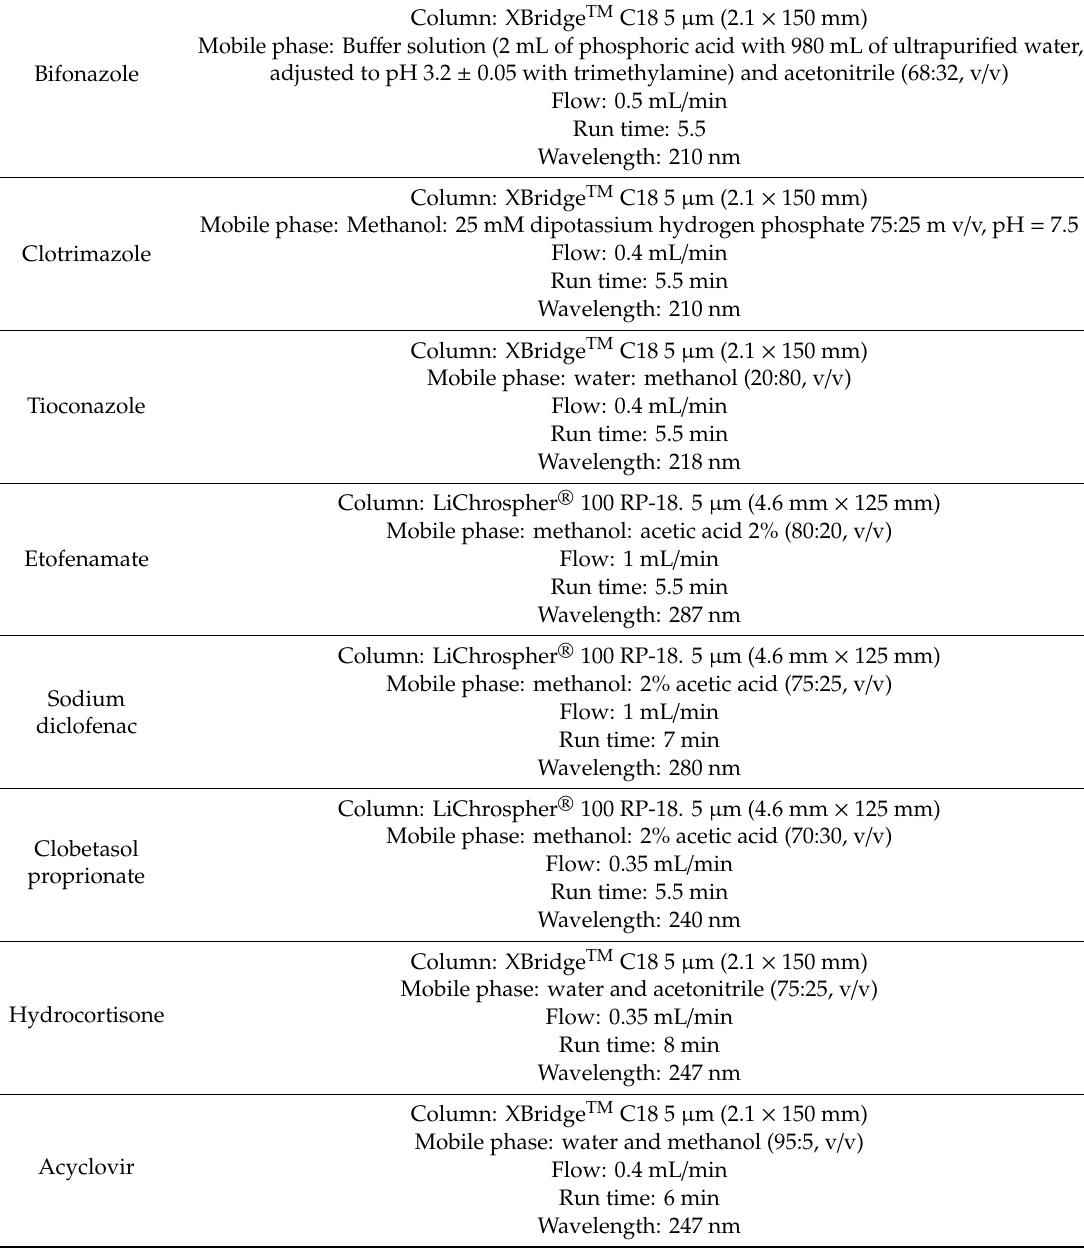
Table 1. Analytical conditions. All developed methods are isocratic and relate to a 10 µ L injection volume.